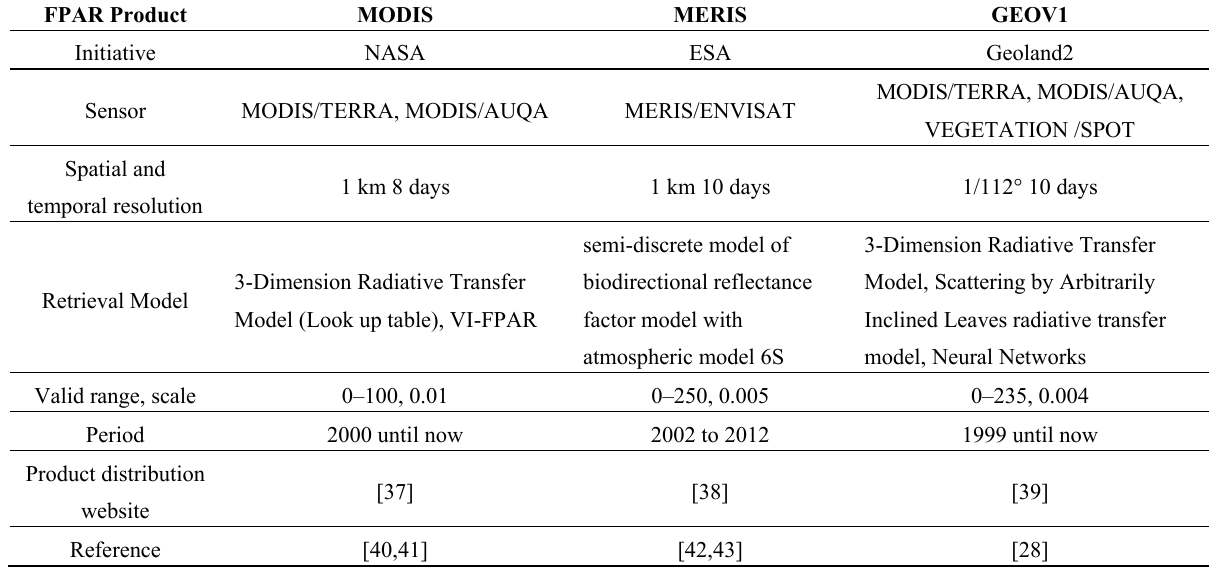
Table 3. Introduction of MODIS, MERIS and GEOV1 FPAR